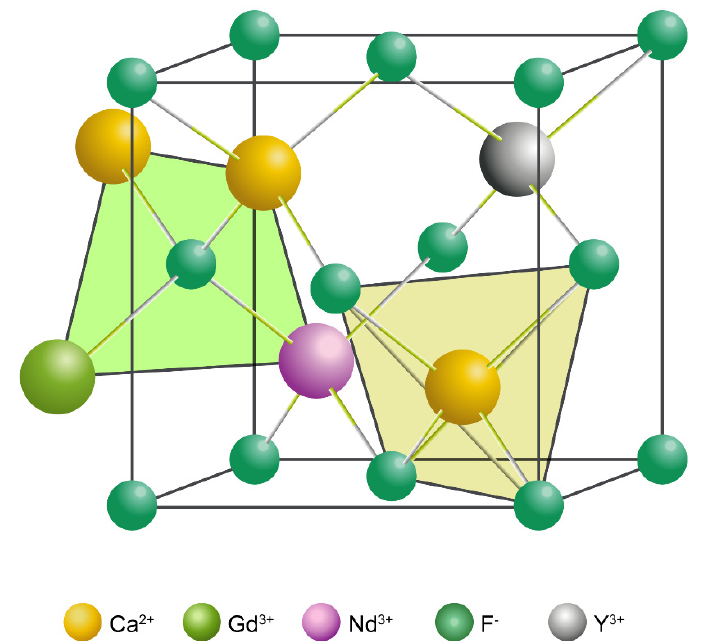
Figure 1. Predicted three-dimensional (3D) structure of CaF 2 :Y,Gd,Nd NPs.